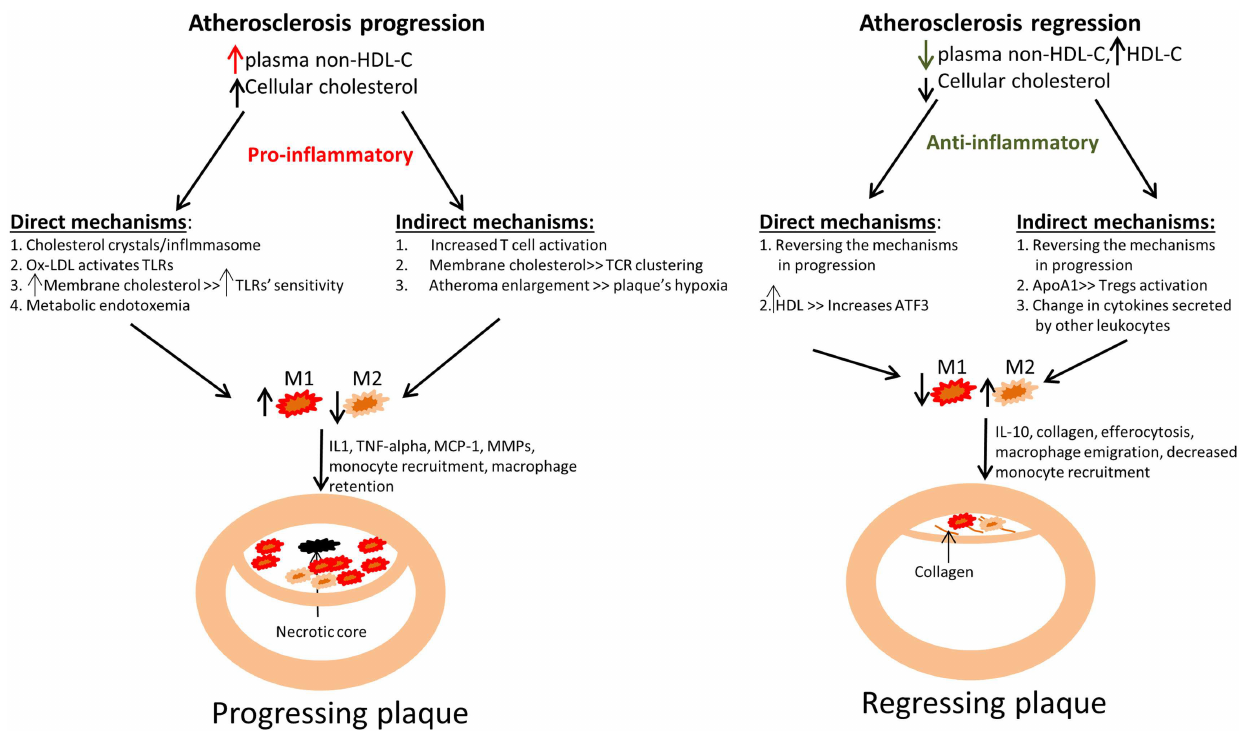
FIGURE 1 | Summary of how changes in plasma cholesterol level and in cellular cholesterol content affect macrophage polarization and kinetics in atherosclerotic plaque progression and regression . Left panel: An increase in non-HDL cholesterol (mainlyVLDL cholesterol and LDL cholesterol) in mouse models has been linked to an increase in monocyte recruitment into atherosclerotic plaques, with their subsequent polarization to M1 macrophages, which are retained.This ultimately leads to atherosclerotic plaque progression, as evident by plaque enlargement. The failure to clear dead macrophages by efferocytosis results in the appearance of the necrotic core. Right panel: An opposite effect has been demonstrated in atherosclerosis regression models, where a reduction in non-HDL-C or a selective increase in HDL-C (representing an increase in functional HDL particles) induces a decrease in plaque size and